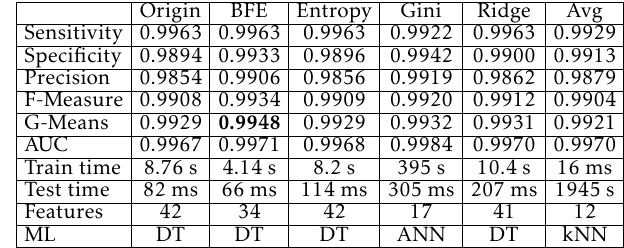
Table 34. Compare CA-BFE with other algorithms on EXPLOITS.